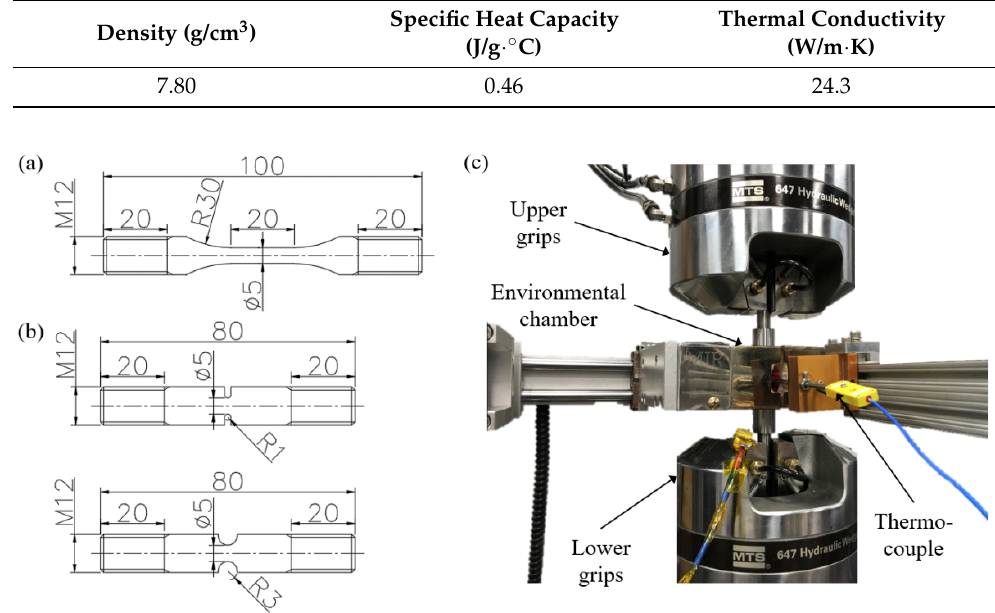
Figure 2. Specifications of uniaxial and notched specimens and an environment of testing machine setup. All dimensions are denoted in mm. ( a ) Dimensions of uniaxial specimen designed, based on the ASTM E8 and ASTM E466 standards. ( b ) A notched specimen dimensions. ( c ) The experimental setting for static and fatigue tests of MTS Landmark servo-hydraulic test system.